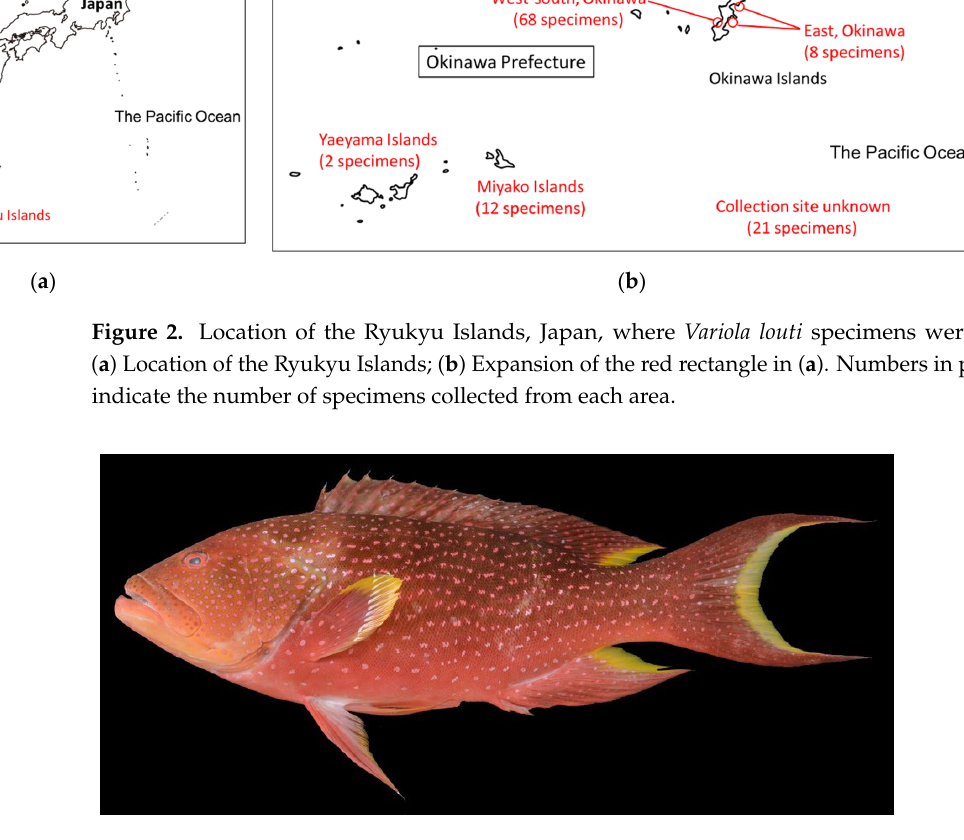
Figure 3. The grouper, Variola louti (Serranidae).